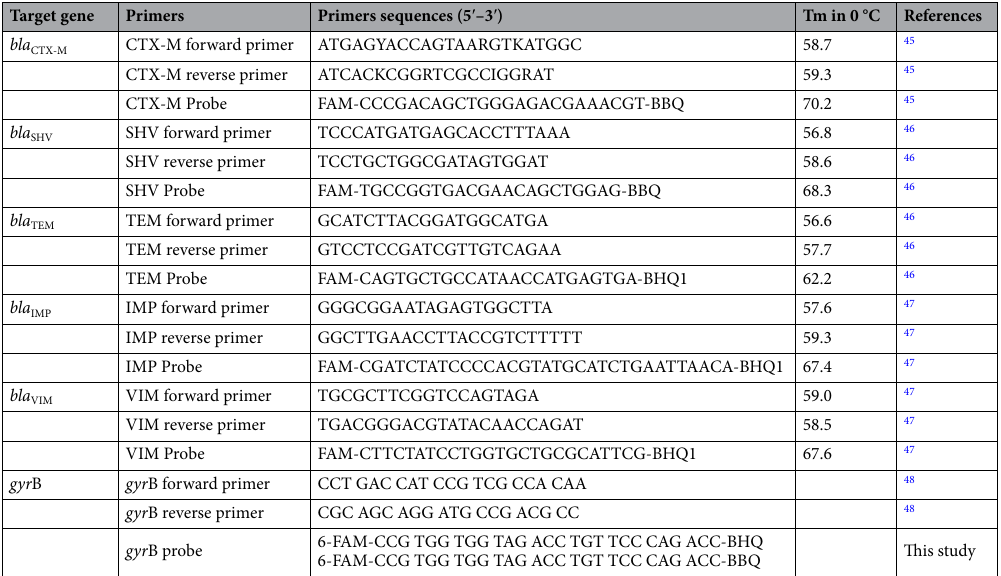
Table 3. Primer sequences for detection of bla CTX-M , bla SHV , bla TEM , bla IMP, bla VIM genes and gyrB.